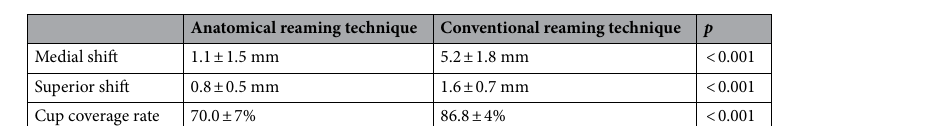
Figure 4. Finite element analysis models of the sawbone were developed and analyzed using MSC.Marc/ Mentat2005r3 software. ( A ) Illustration of the measurement points for micromotion between the interface of the cup and host bone around the acetabulum. ( B , C ) The locations of 5 points from two different perspectives.